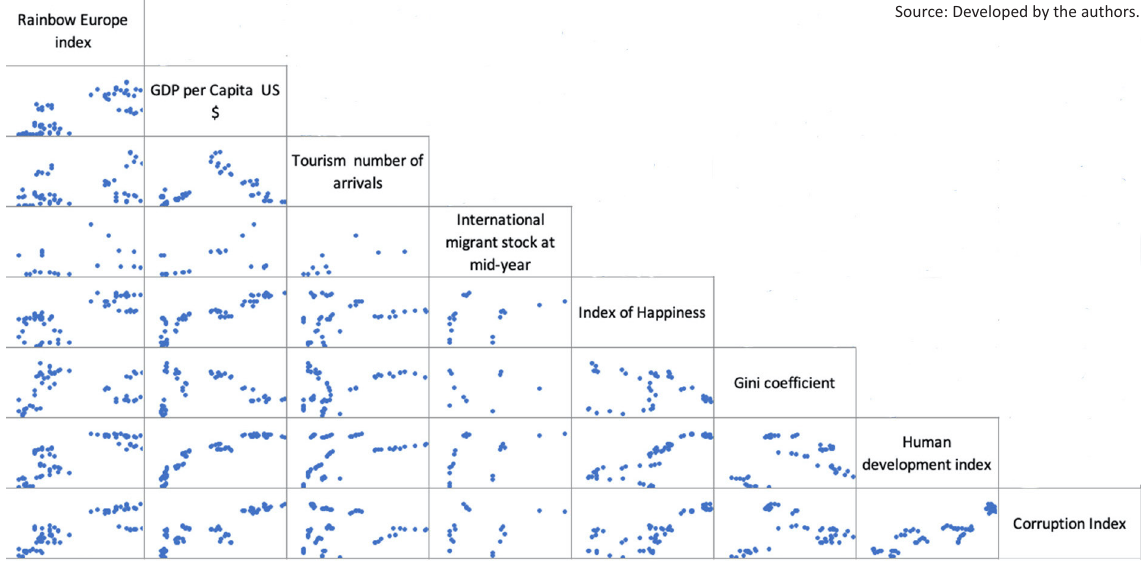
Figure 1. Relationship between the Rainbow Europe Index and other indicators,